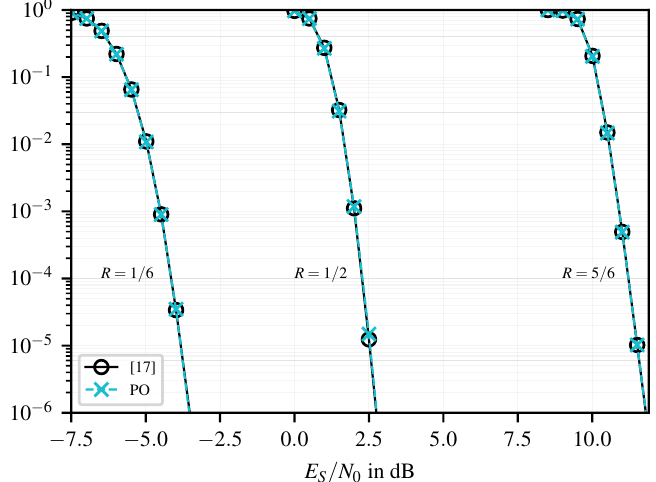
Figure 8. Error-correction performance of Polar codes with N = 1024 and R SCL and PO-Fast-SSCL decoding with L = 16.